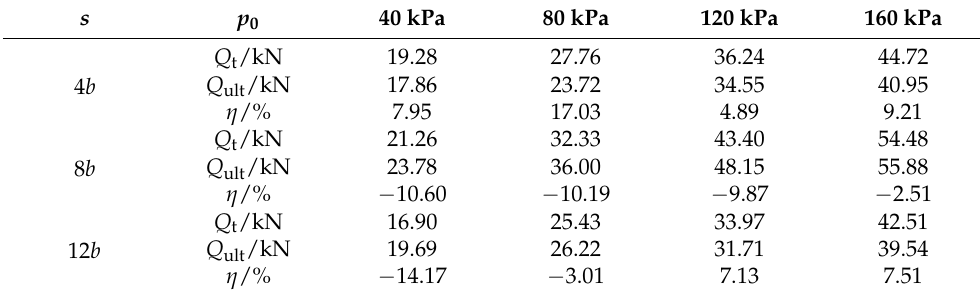
Table 5. Comparison between the theoretical and measured